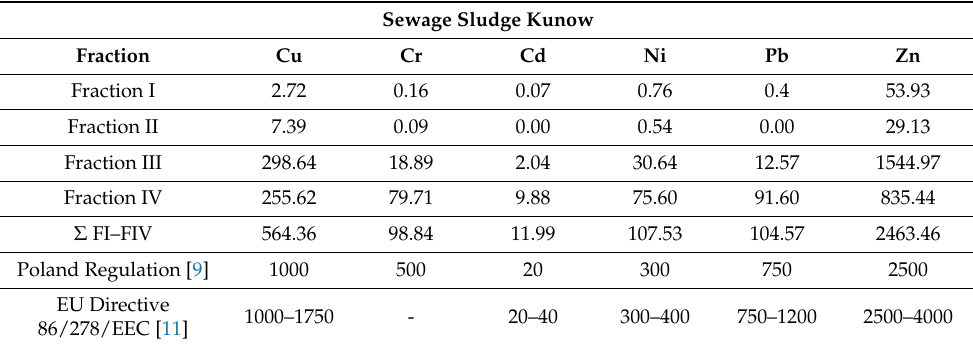
Figure 4. Percentage of metals in the FIII and FIV fractions of the sludge of WWTP. Sewage sludge from Kunow did not exceed the limits of heavy metals content; only zinc was on the border of the limit value of the applicable standard [9] and amounted to 2463.46 mg/kg d.m., of which 62.71% was contained in fraction FIII (Tables 7 and 8). For chromium, cadmium, nickel, and lead, the highest content was recorded for fraction FIV: respectively, Cr 80.64%, Cd 82.40%, Ni 70.31%, and Pb 87.6%. On the other hand, copper dominated in fraction FIII (52.92%). Table 8. Chemical speciation of heavy metals in sewage sludge from the Kunow wastewater treatment plant in the Swietokrzyskie Voivodship (mg/kg).